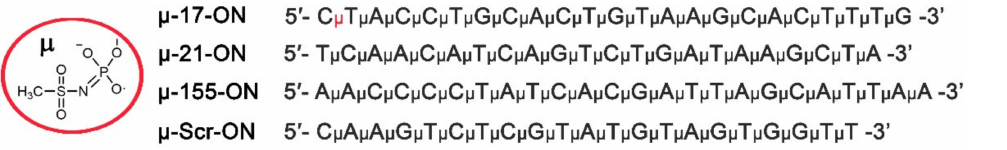
Figure 1. Structure of mesyl phosphoramidate ( µ -) modification and sequences of oligonucleotides used in the study. µ -17-ON, µ -21-ON and µ -155-ON are µ -modified oligonucleotides, targeted to miR-17, miR-21 and miR-155, respectively. µ -Scr-ON represents control µ -oligonucleotide that has no targets in the mammalian